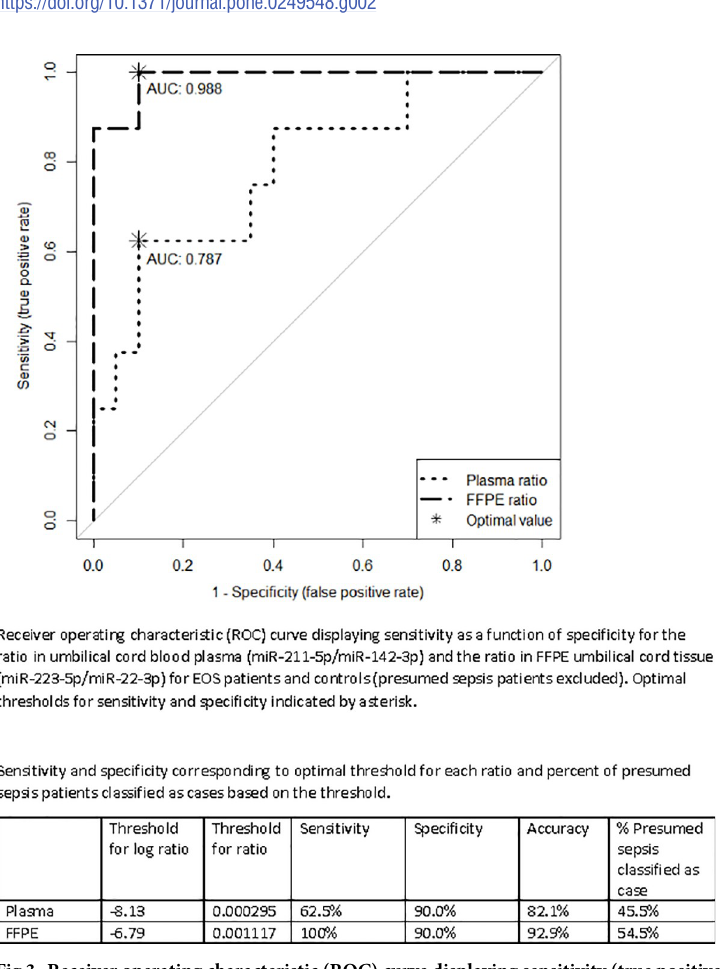
Fig 3. Receiver operating characteristic (ROC) curve displaying sensitivity (true positive rate) as a function of 1 – specificity (false positive rate) for ratio in cord blood plasma (miR-211-5p/miR-142-3p) and the ratio in FFPE cord tissue (miR-223-5p/miR-22-3p) for EOS patients and controls (presumed sepsis patients excluded). https://doi.org/10.1371/journal.pone.0249548.g003 PLOS ONE | https://doi.org/10.1371/journal.pone.0249548 May 7,